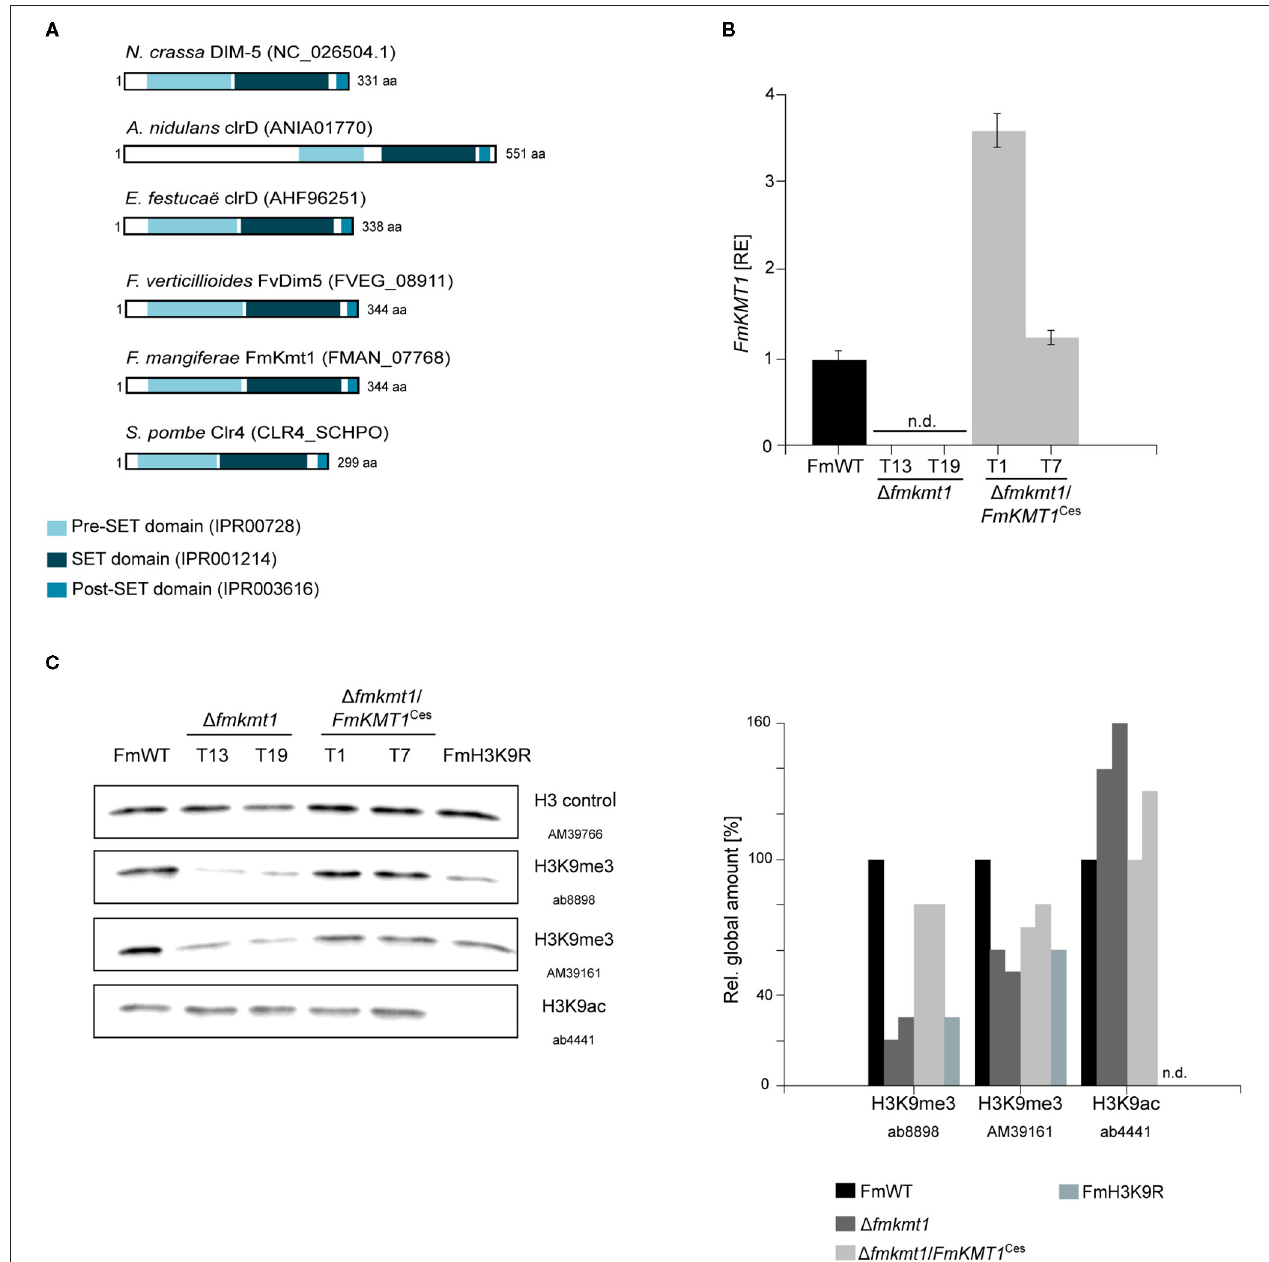
FIGURE 1 | FmKmt1 is involved in H3K9me3 in F. mangiferae . (A) Graphical representation of the domain structure of Neurospora crassa DIM-5 and orthologs in other fungal species including F. mangiferae (FmWT). The conserved pre-Set domain, SET domain, and post-SET domain are indicated; InterPro accession numbers are shown in the domain description (B) For FmKMT1 expression analysis, FmWT, 1 fmkmt1 , and 1 fmkmt1 / FmKMT1 Ces were grown on solid CM for 3 days at 30 ◦ C. For the determination of transcript levels, RNA was extracted and transcribed into cDNA prior to RT-qPCR. The FmWT FmKMT1 expression was arbitrarily set to 1. Mean values and standard deviations are shown. n.d., not detected; RE, relative expression. (C) Western blot analysis of FmWT, 1 fmkmt1 , 1 fmkmt1 / FmKMT1 Ces , and FmH3K9R using two anti-H3K9me3-specific antibodies (AB, Abcam; AM, Active Motif), and one anti-H3K9ac-specific antibody. For referencing one anti-H3-specific antibody was used. Indicated strains were grown in liquid ICI medium supplemented with 120mM NaNO 3 for 4 days and subsequently total proteins were extracted. Roughly, 50 µ g of total protein extracts were separated on a SDS gel prior to western blotting. For quantification, a densitometric analysis was performed and the respective wild-type strain was arbitrarily set to 100%. n.d., not detected via Image J analysis tool. exchanged ( Supplementary Figure 5 ). Subsequent